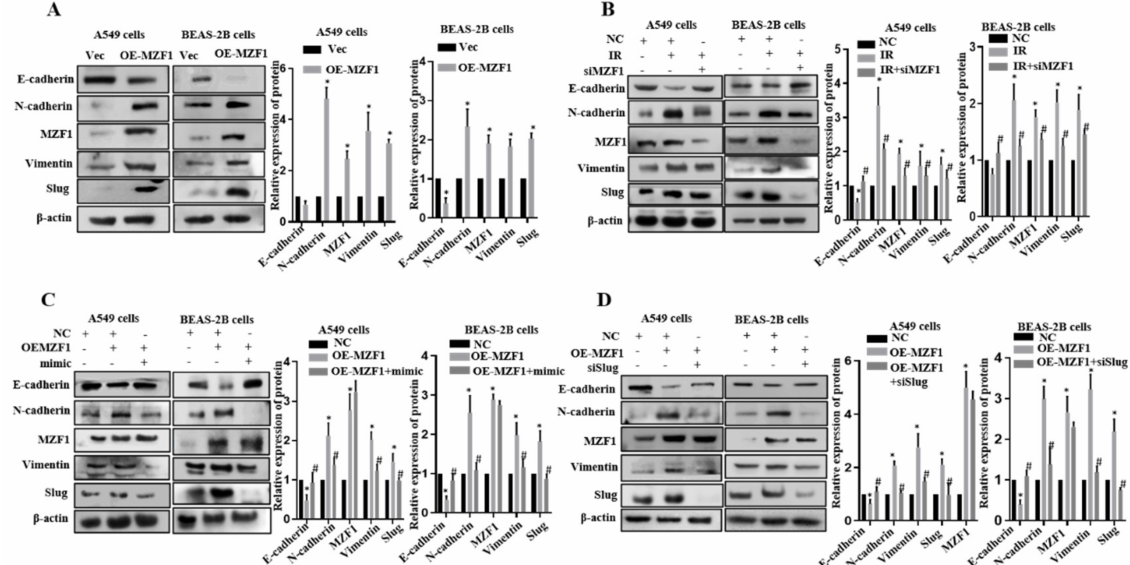
Figure 6. MZF1 promoted EMT by repressing the miR–541–5p expression upon IR. ( A ) Overexpression of MZF1 in A549 cells and BEAS–2B cells to observe changes in EMT–related protein levels. The bar graph presents the results of the gray value analysis. ( B ) Western blot experiments were performed to verify whether the IR-induced changes in the EMT–related proteins were inhibited upon the knockdown of MZF1 in A549 cells and Beas 2B cells. The bar graph presents the results of the gray value analysis. * p < 0.05 versus the control; # p < 0.05 versus IR. ( C ) Co–transfection of MZF1 with the miR–541–5p mimic in cells to observe the changes of the EMT–related proteins and target genes. ( D ) Co–transfection of MZF1 with siSlug in cells to determine the EMT–related protein. Data represents the mean ± SEM ( n = 3), * p < 0.05 versus control of the same group; # p < 0.05 versus OE-MZF1 of the same